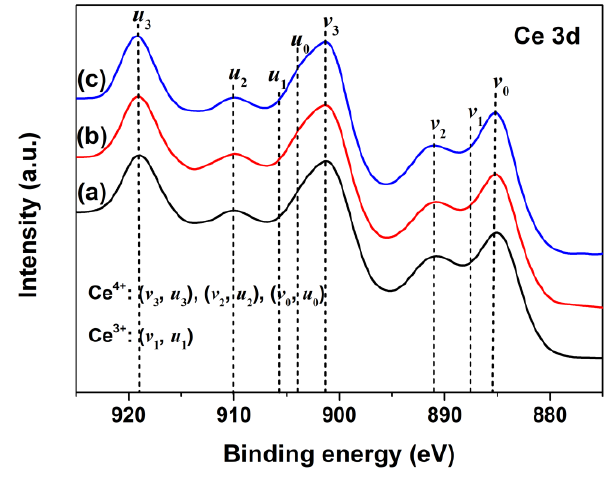
Figure 3. Ce3d XPS spectra of ( a ) Undoped, ( b ) 1% Pr- and ( c ) 2% Pr-doped CeO 2 . To investigate the changes of chemical states of oxygen in CeO 2 with Pr doping, the O1s XPS regions and respective fitting curves of Undoped, 1% and 2% Pr-doped CeO 2 were recorded, and the results are shown in Figure 4. The O1s XPS spectra of Undoped CeO 2 could be curve-fitted into two peaks, indicative of the presence of two kinds of oxygen species on the CeO 2 surface. The peak at about 529.1 eV (labeled as α ) could be assigned to the lattice oxygen of O-Ce species, whereas that of about 531.5 eV (labeled as β ) could be assigned to the chemisorbed oxygen species or/and weekly bonded oxygen species related to the oxygen vacancies (labeled as V O ). The β peak that appeared in Undoped CeO 2 indicated that pure CeO 2 itself possessed a certain number of V O defects. Considering the traces of the Pr element in doping CeO 2 , the O1s XPS spectra of 1% and 2% Pr-doped CeO 2 were also curve-fitted into two peaks. Compared to the binding energy of the O1s spectrum in Undoped CeO 2 , there was a blue shift of 0.3 eV for 1% Pr-doped CeO 2 and 0.4 eV for 2% Pr-doped CeO 2 , respectively. The blue shift of O1s peaks suggested the reduction of the valence state of lattice oxidation from O-Ce species; in other words, Pr-doping benefited the V O species in creation. The rising numbers of V O species in CeO 2 could be attributed to the incorporation of Pr 3+ into the CeO 2 lattice to form solid solutions. The substitution reaction of Ce 4+ cation by Pr 3+ cation could be written in Kroger and Vink notations, as expressed by Equation (2):